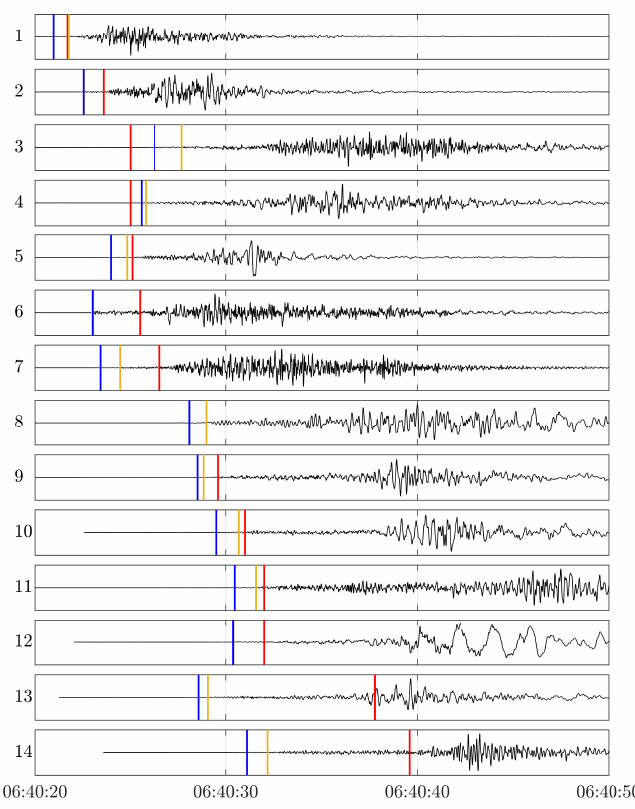
Figure 3. Seismograms of the radial acceleration component for the strong-motion (SM) stations, which are colocated with GNSS stations at distances smaller than 5 km. These sites are marked with ID 1–14. The vertical bars indicate the detected first arrivals: Red for GNSS, light brown for the SM radial component (automatic picking), and blue for the SM radial component (manual picking).